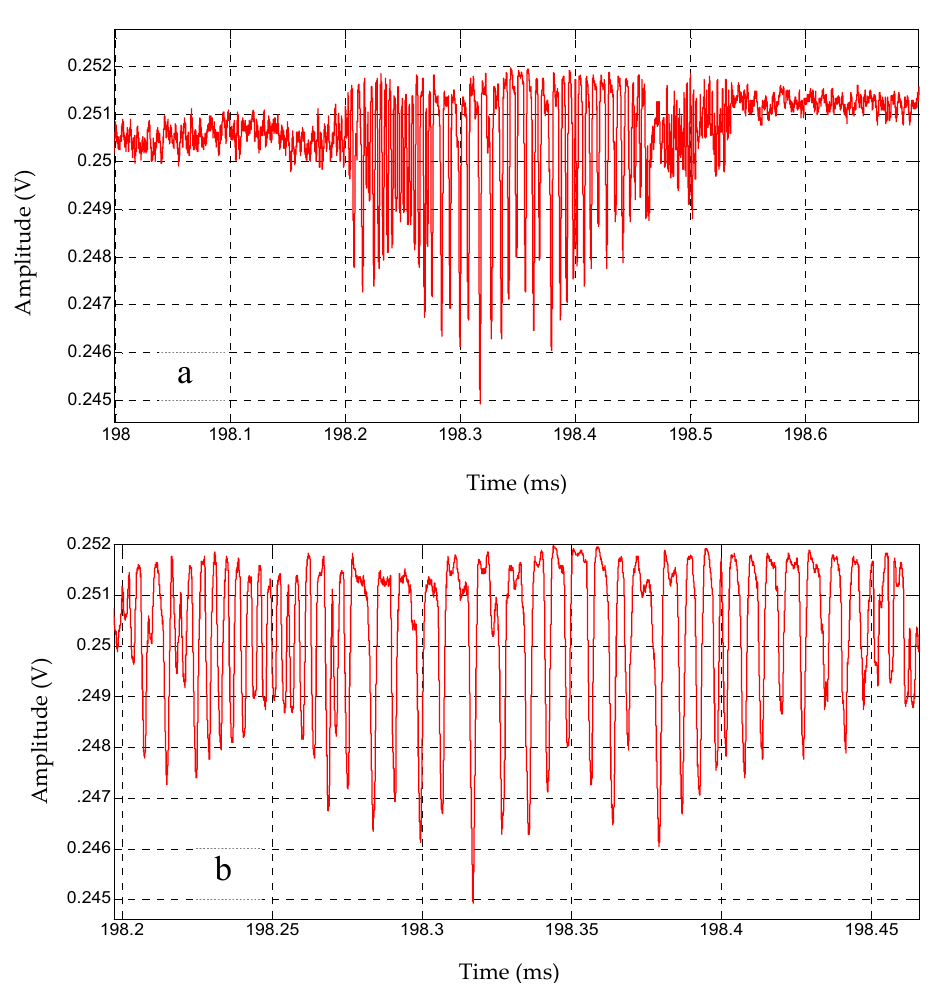
Figure 8. ( a ) K-change consists of a regular pulse train probably followed by a chaotic pulse train, ( b ) Expanded view of the regular pulses. Data were recorded on 4/5/2013 20:08:00. UTC.